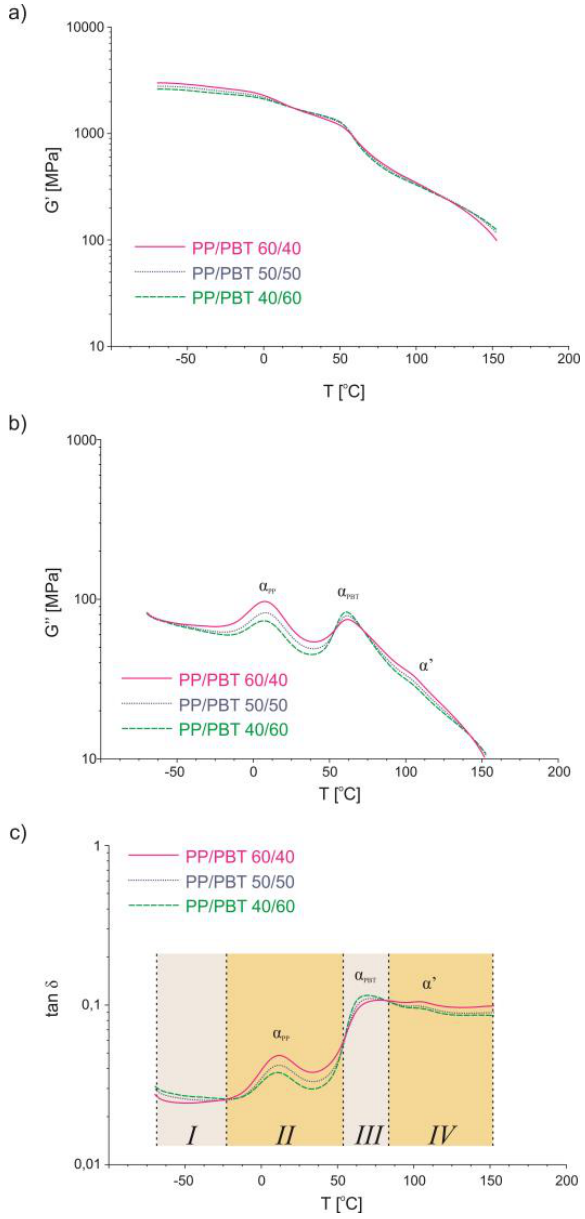
Figure 14. DMTA analysis of uncompatibilized PP / PBT blends: ( a ) storage modulus; ( b ) loss modulus; ( c ) tangent of delta.